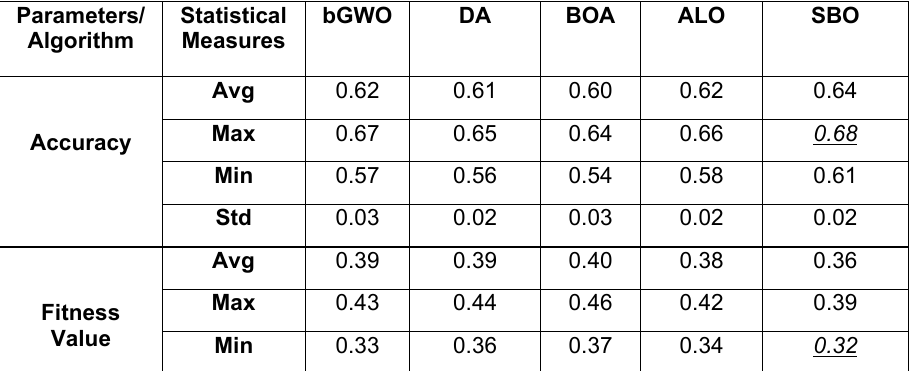
Table 4. Statistical Analysis of